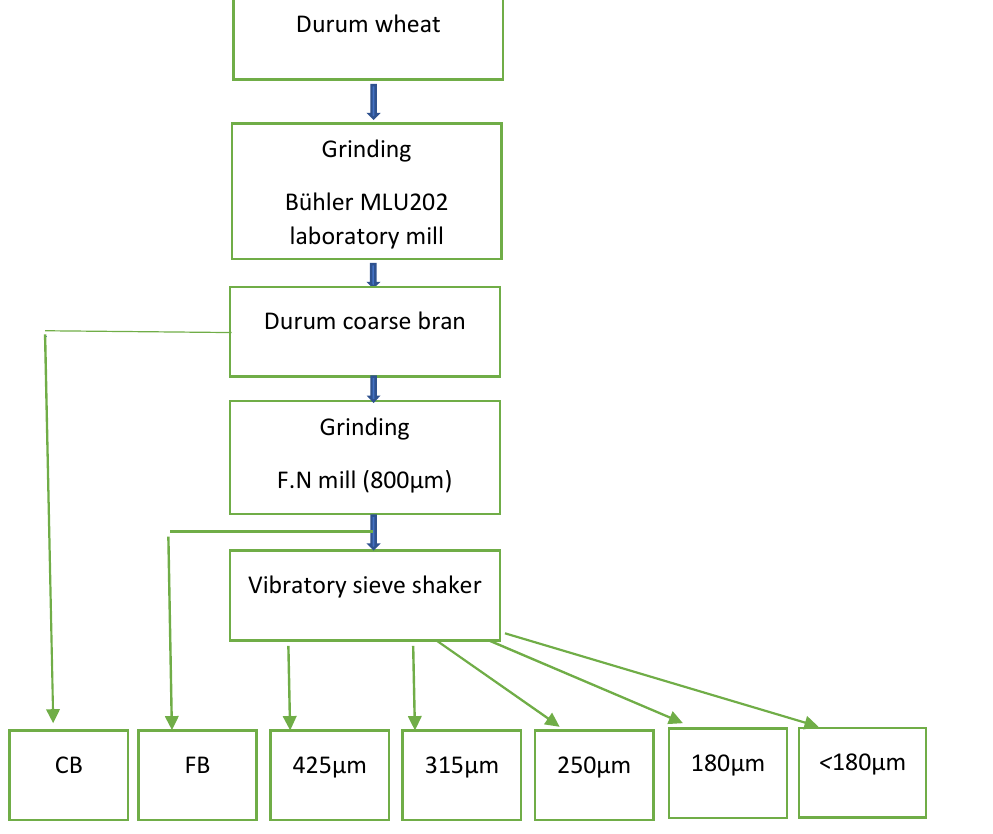
Figure 1. Flow chart for preparing durum bran fractions. F. N = falling number mill. CB; coarse bran. FB; fine bran.